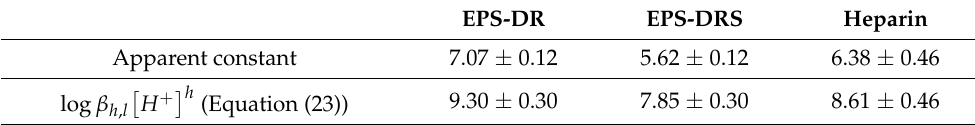
Table 5. Complexation constants obtained by FISRE for different ligand. Charges are omitted for the sake of simplicity.